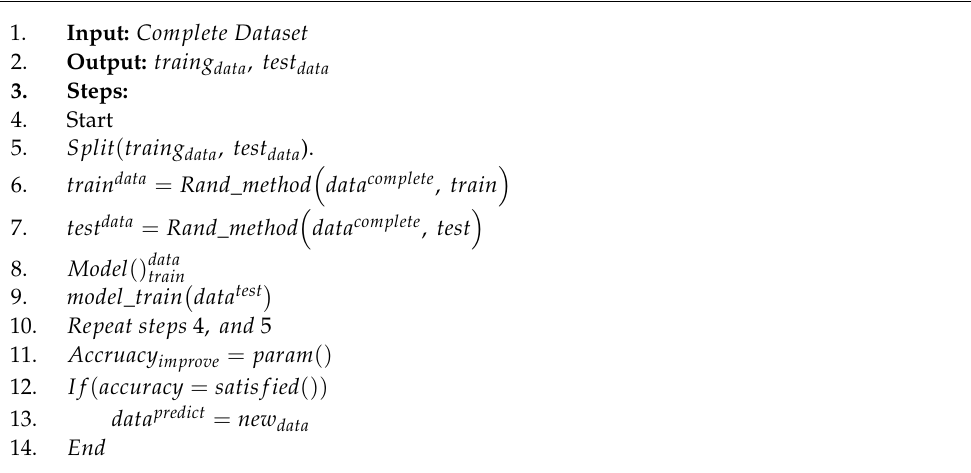
Algorithm 5: Decision about training and testing